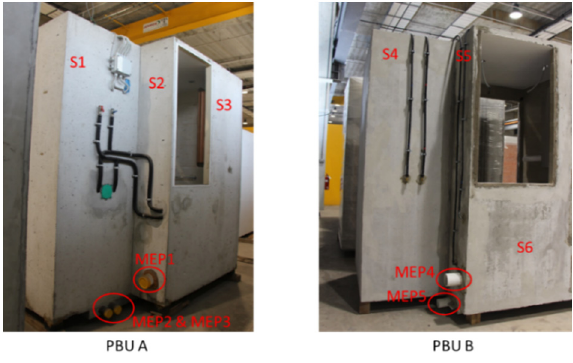
Figure 20. Two PBUs for validation experiments.